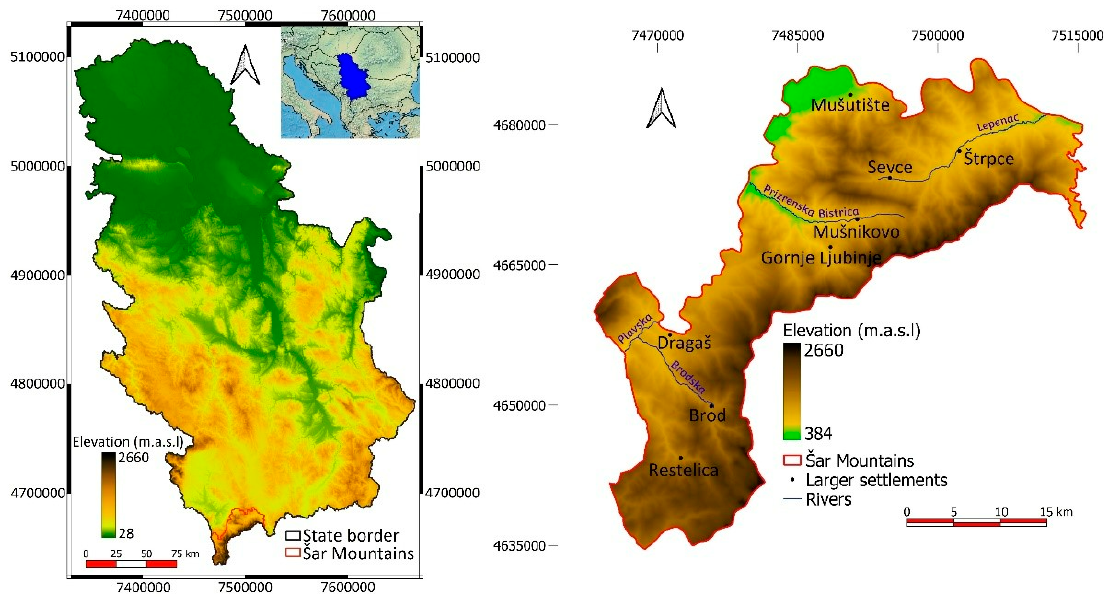
Figure 1. Geographical position of the Šar